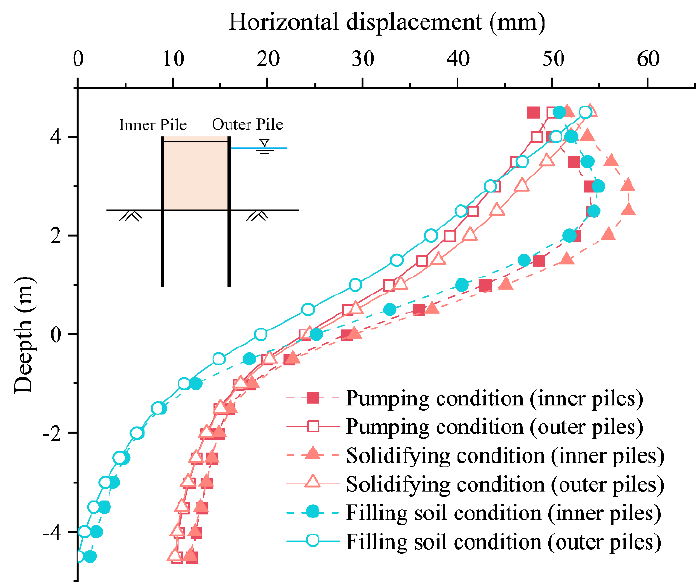
Figure 10. Horizontal displacement curve of piles at different stages.